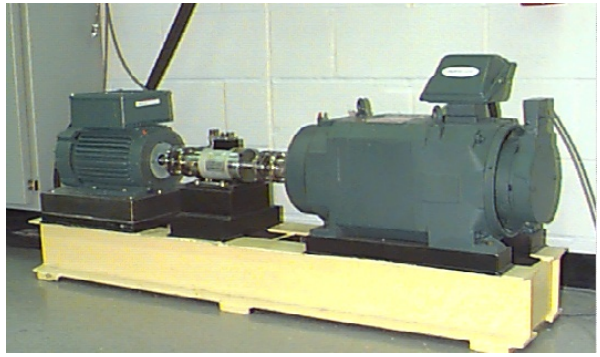
Figure 8. CWRU bearing test rig